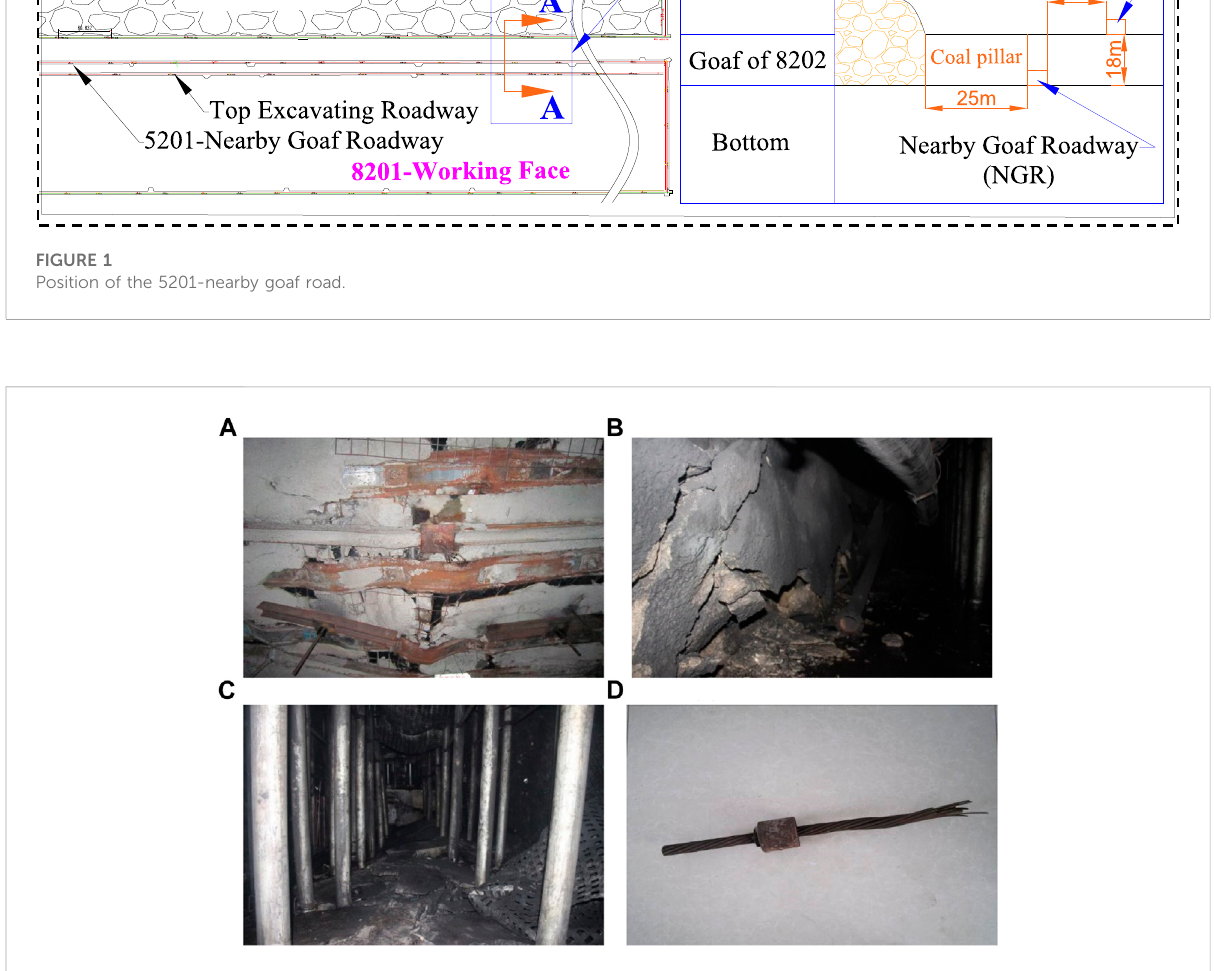
FIGURE 2 Failure state of the surrounding rock in the nearby goaf